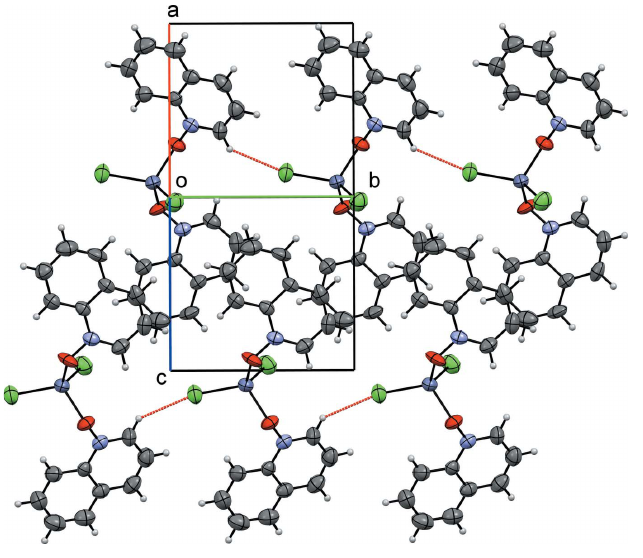
Figure 5 Crystal packing diagram of compound ( I ), viewed down the [101] direction.